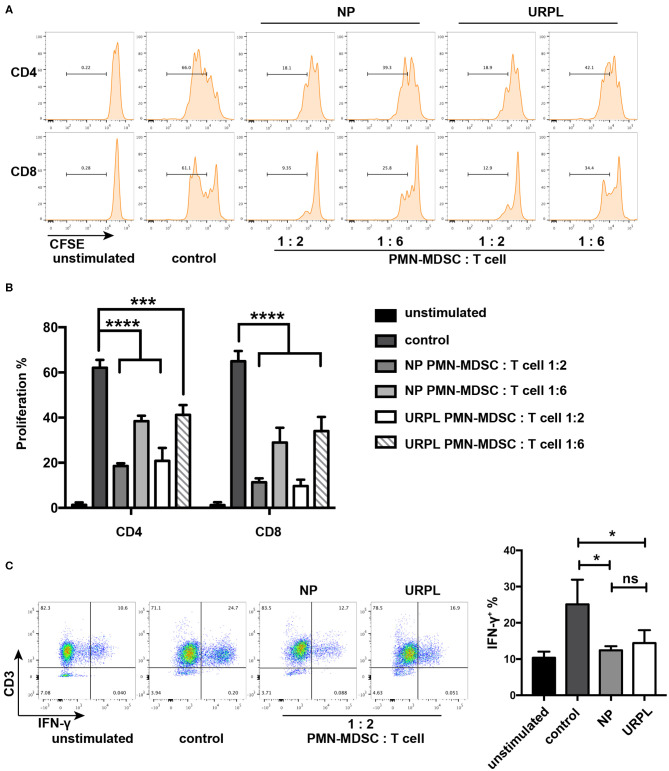
Functional characteristics of decidual PMN-MDSC in the NP group and URPL group. (A) and (B) CD3/CD28-stimulated T cells were cocultured with purified PMN-MDSC of the NP group and the URPL group from decidua of pregnancy between 6 and 9 weeks at a ratio of 2:1 or 6:1 for 3.5 days. The percentage of proliferative CD4+ T cells or CD8+ T cells were analyzed (mean ± SD, one-way ANOVA, Tukey's post-hoc test). (C) CD3/CD28-stimulated T cells were cocultured with purified PMN-MDSC of the NP group and the URPL group from decidua of pregnancy between 6 and 9 weeks at a ratio of 2:1 for 3.5 days. Percentage of IFN-γ-expressing T cells were analyzed (mean ± SD, one-way ANOVA, Tukey's post-hoc test). n = 3; *P < 0.05; ***P < 0.001; ****P < 0.0001; ns, not significant.